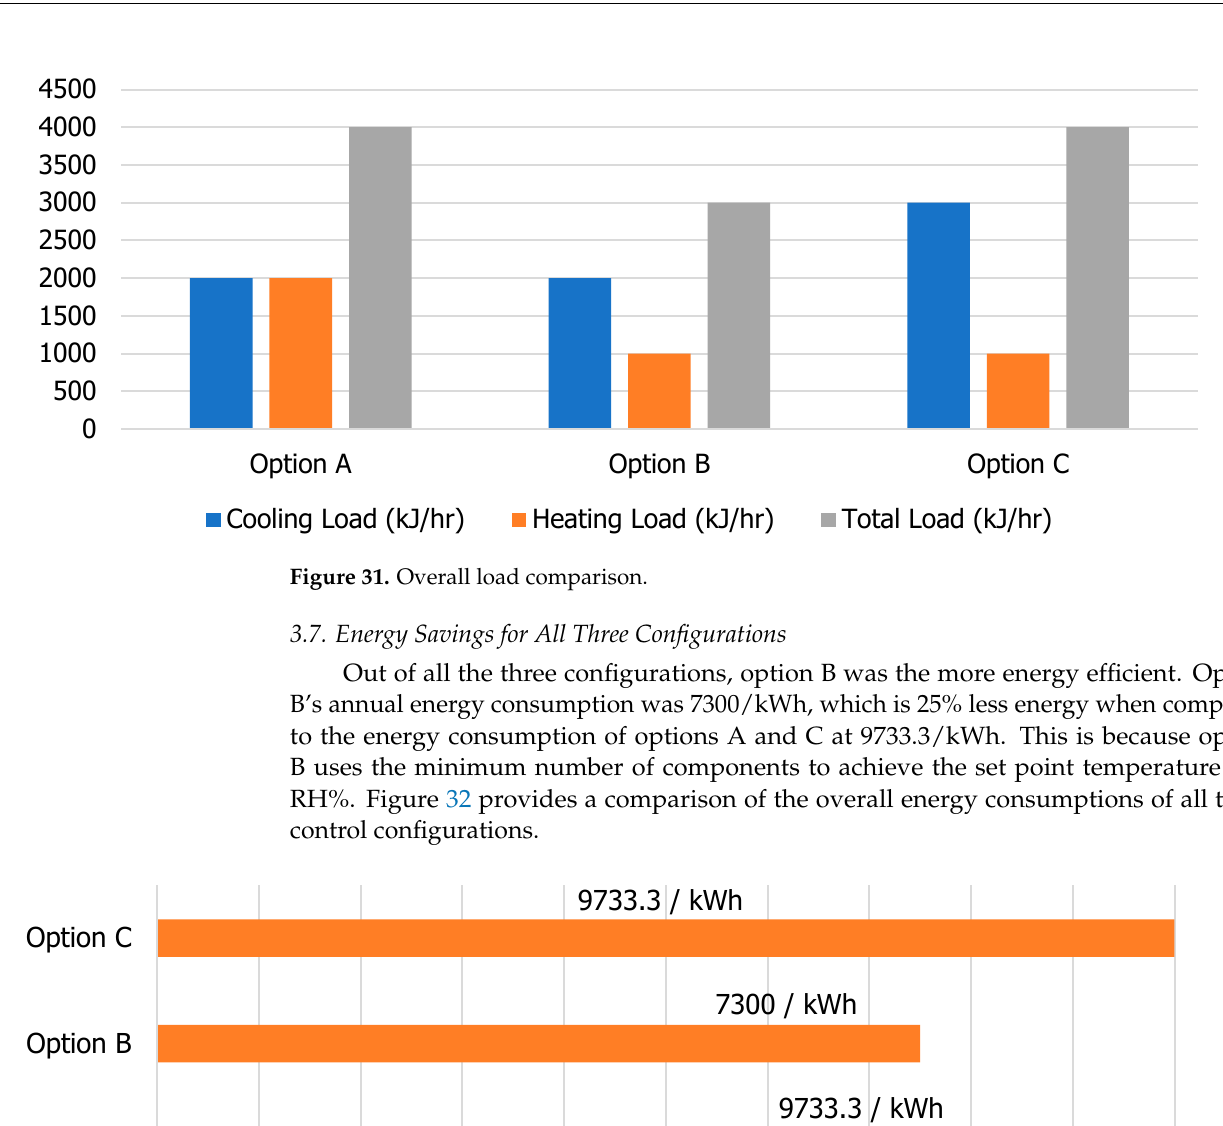
kWh × 1 metric ton/2204.6 lb.